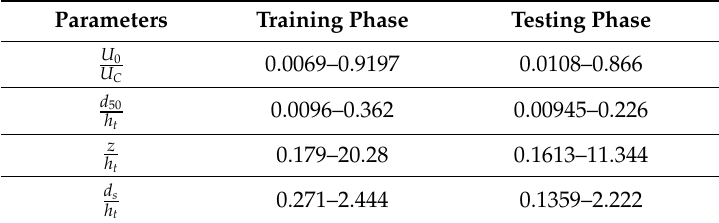
Table 1. Range of the target and input variables employed in the present